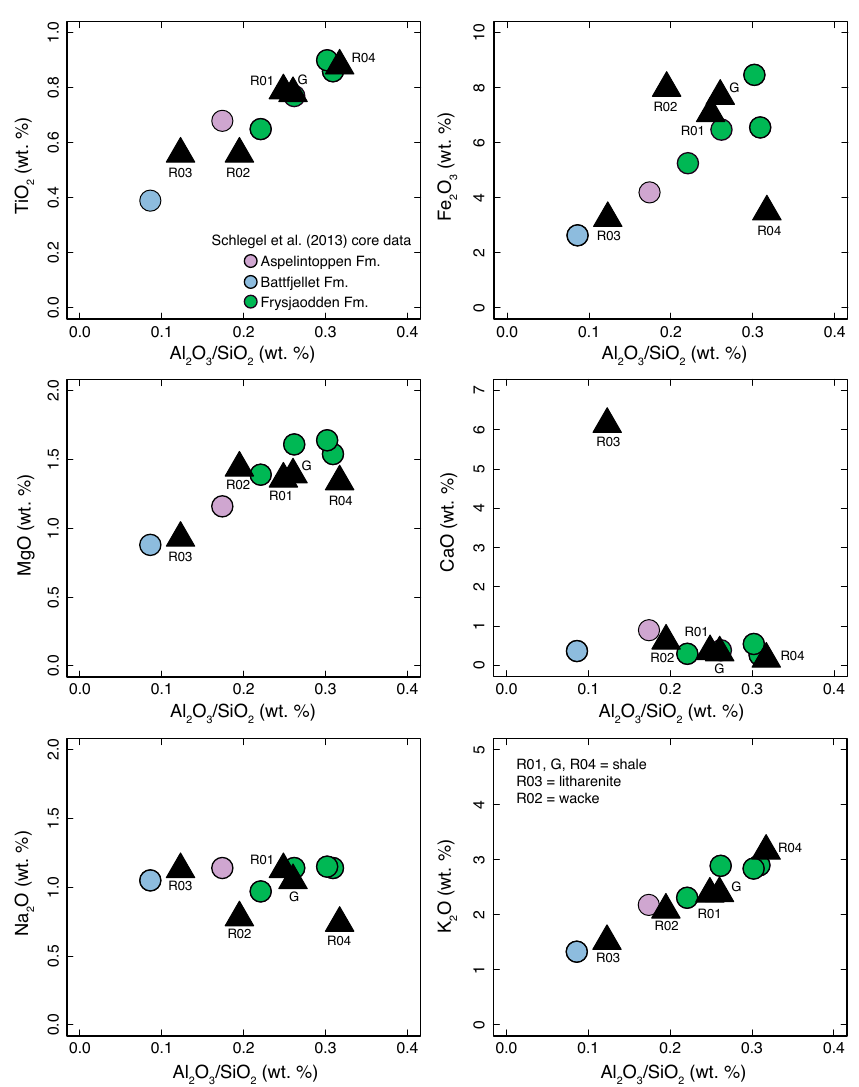
Figure 3. Plots of major elements in the collected rock samples against the Al 2 O 3 / SiO 2 ratio compared with core data (Store Norske Well 11-2003) covering the same formations (Schlegel et al., 2013). Sample R03 contains 10% carbonate, accounting for the high Ca concentration (Hindshaw et al.,